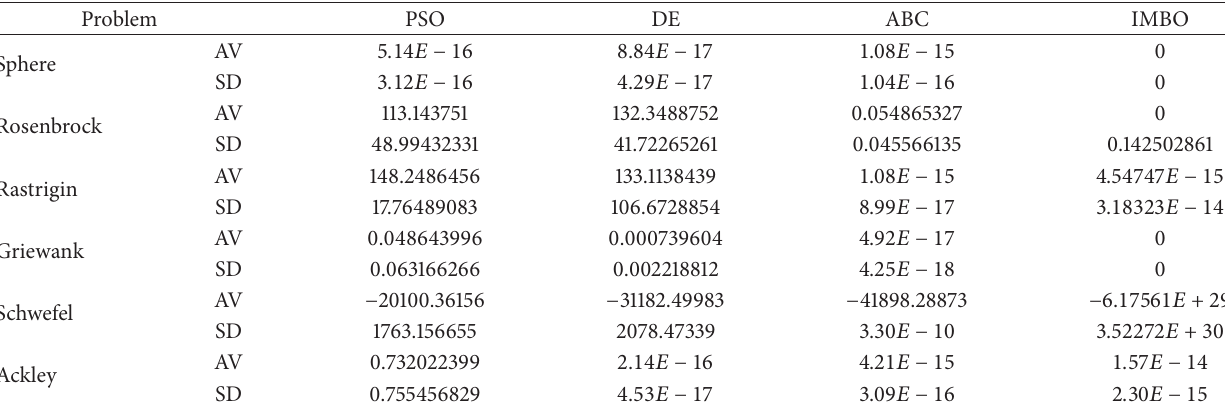
Table 11: The mean solutions obtained by the DE, PSO, ABC, and IMBO algorithms for 6 test functions over 30 independent runs and total success numbers of algorithms. Genotype size: 100; (—): not available value, SD: standard deviation, AV: global minimum average. Problem